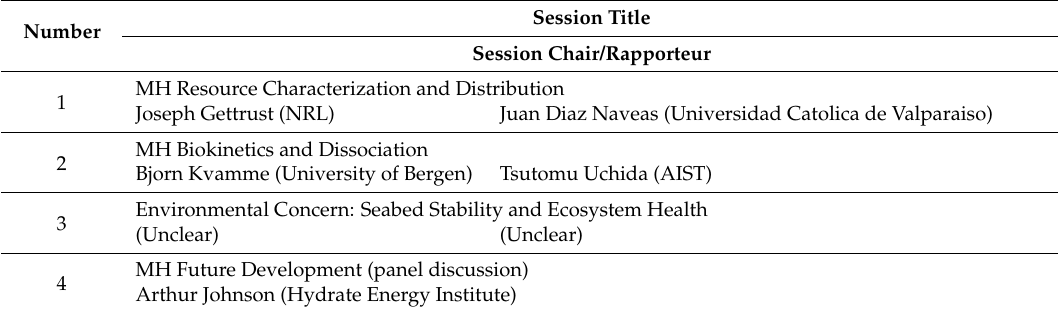
Table 4. Specific Sessions (title and